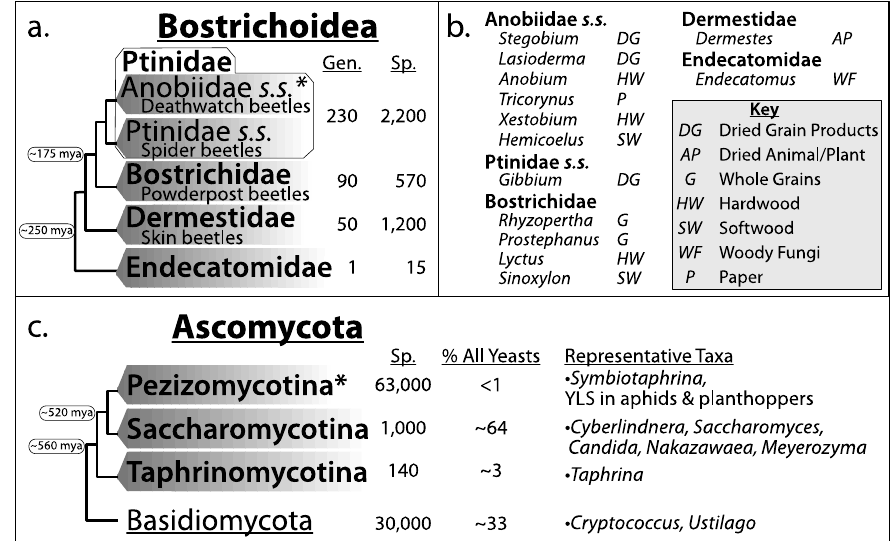
Figure 3. Phylogenetic relationships among beetles—Bostrichoidea ( a ); and fungi—Ascomycota ( c ). The estimated number of genera (Gen.) and species (Sp.) for each family of Bostrichoidea. For each subphylum of Ascomycota and the phylum Basidiomycota, the estimated number of species (Sp.), the fraction of all fungi with yeast-like growth (% all yeasts, e.g., 64% of all yeasts are found in Saccharomycotina), and representative taxa. Representative genera from each beetle family and their common diet ( b ). Asterisks indicate the taxonomic lineages containing the hosts (Drugstore and Cigarette beetles) and the symbiont ( Symbiotaphrina ). Figure adapted from several sources: beetle tree—Bell & Philips (2012) [46], Gearner (2019) [48], McKenna et al. (2019) [49]; fungal tree—Nagy et